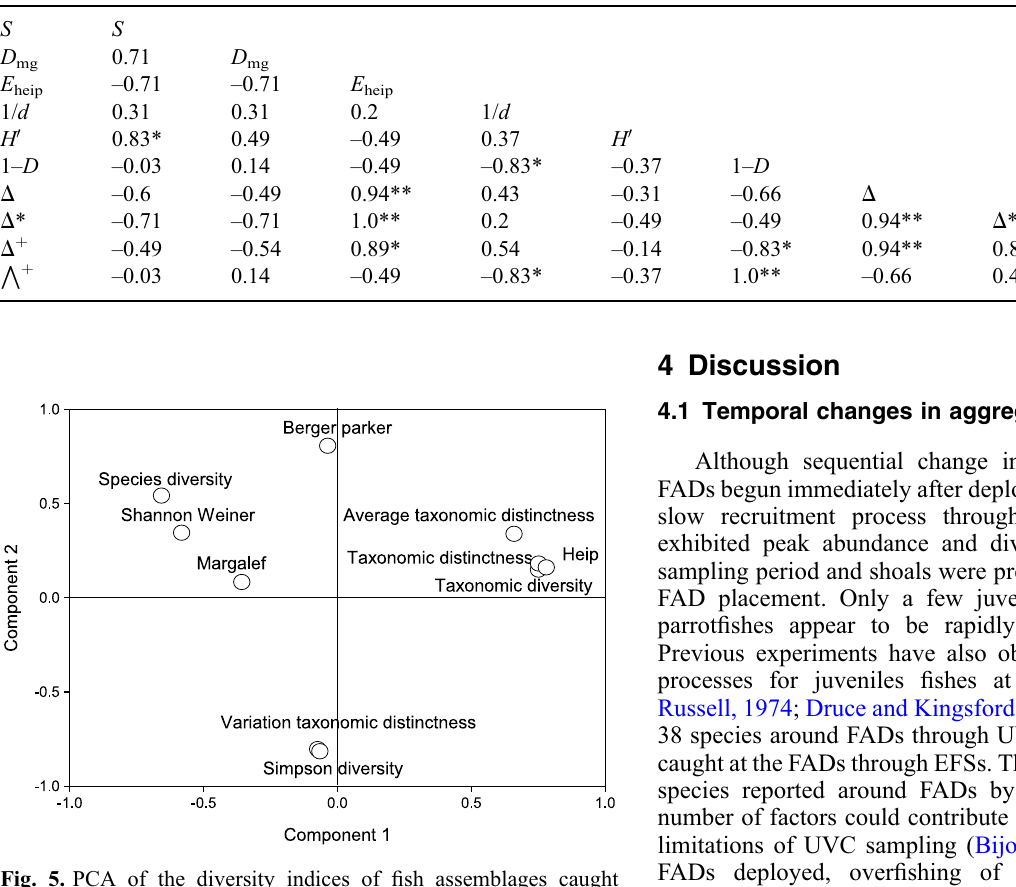
Fig. 5. PCA of the diversity indices of fi sh assemblages caught around the FADs in coastal Kenya. Indices descriptors as in Table